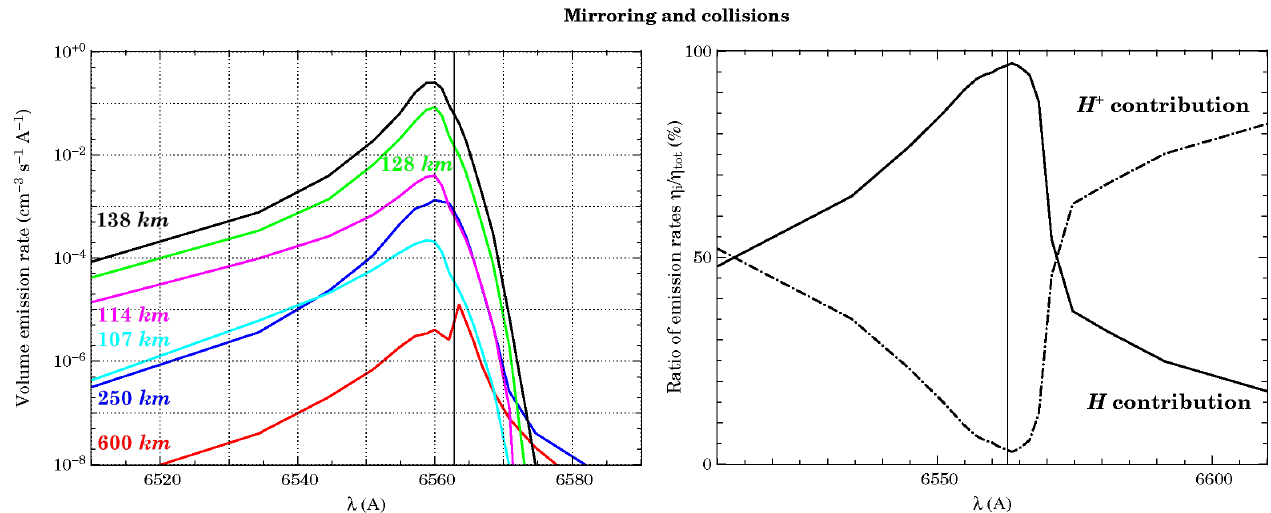
Fig. 7. H α spectra yielded by TRANS4 when taking into account angular redistributions of both magnetic and collisional origins under Rutherford’s approximation for the phase function. The left panel is the detail of altitude contributions to the total volume emission rate. The same colour code as in Fig. 4 is used: 107km (cyan), 114km (magenta), 128km (green), 138km (black), 250km (blue) and 600km (red). In the right panel, the ratio of the contributions of proton (dash-dot) and hydrogen (solid line) to the total H α emission rate is plotted.